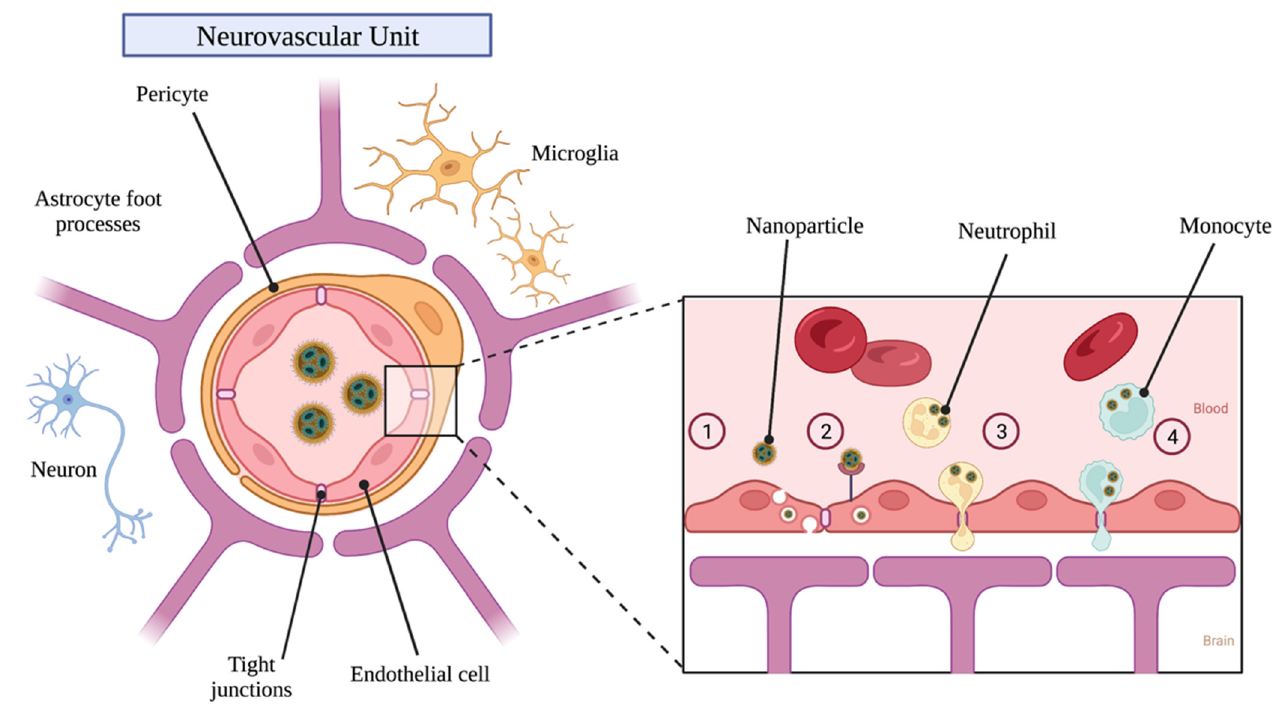
Figure 2. Nanoparticle transport across the blood–brain barrier. (1) Adsorptive-Mediated Transport. (2) Receptor-Mediated Transport. (3) Neutrophil-Mediated Delivery. (4) Monocyte-Mediated Delivery.